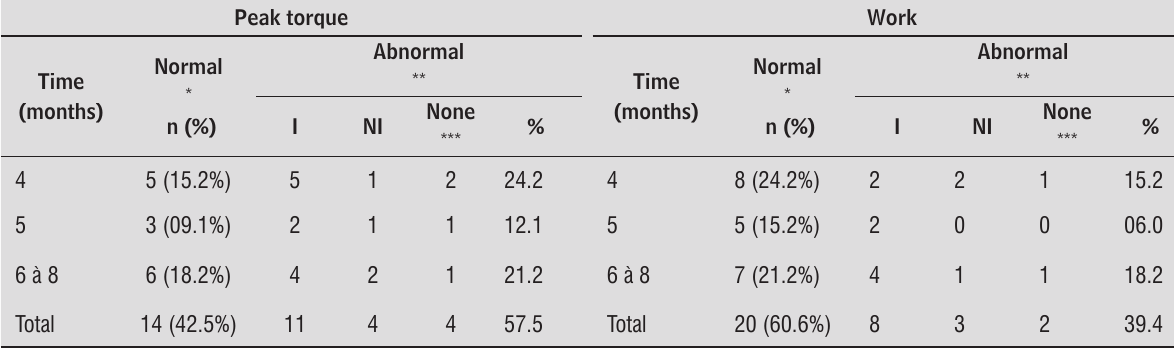
Table 3 - Distribution of cases among the variables (absolute value and